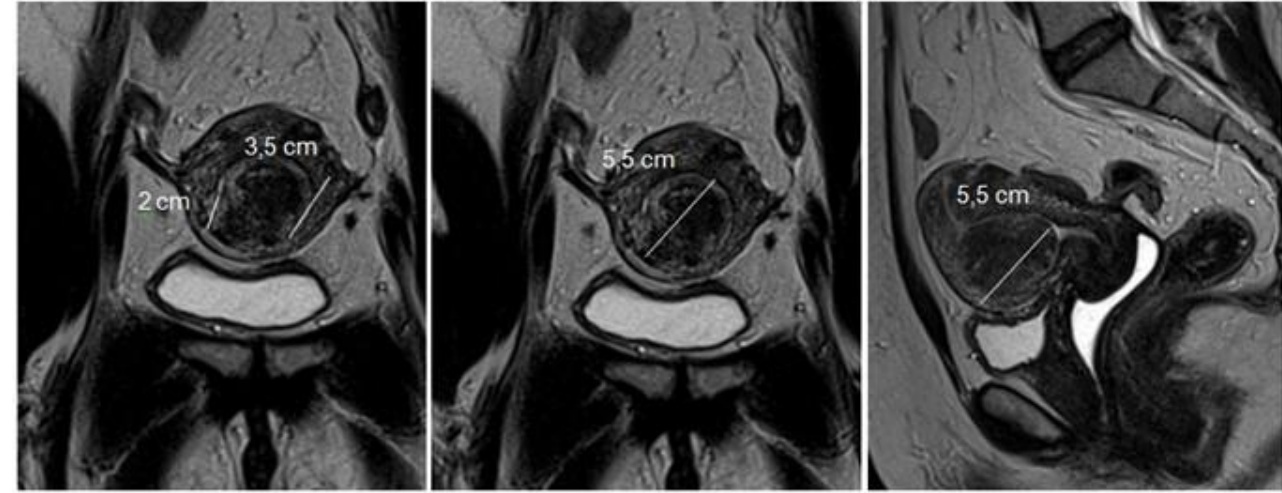
Figure 5. The effect of nearby fibroids.